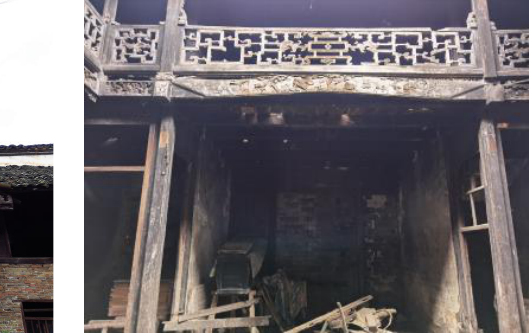
Fig. 2. Photo of damage of ancient building